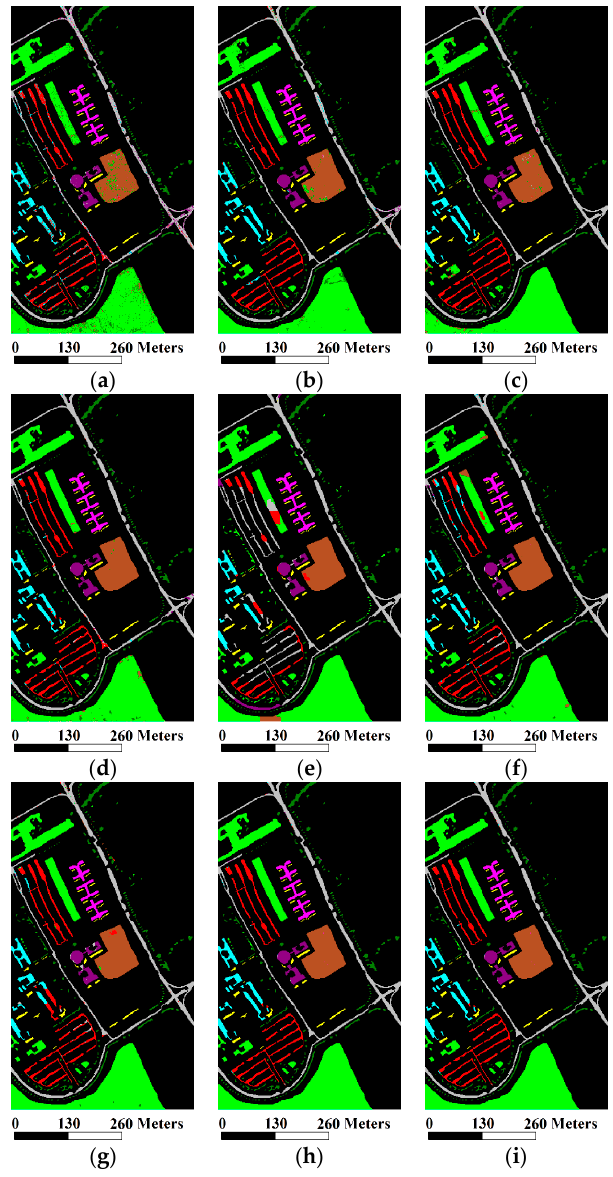
Figure 5. Classification maps for the University of Pavia data set by different methods: ( a ) SVM; ( b ) SS-Kernel; ( c ) EMP; ( d ) EPF_JBF; ( e ) MLR-LORSAL; ( f ) LBP-AL; ( g ) LORSAL-AL-MLL; ( h ) CS-GC; and ( i ) CS-GC + JBF.